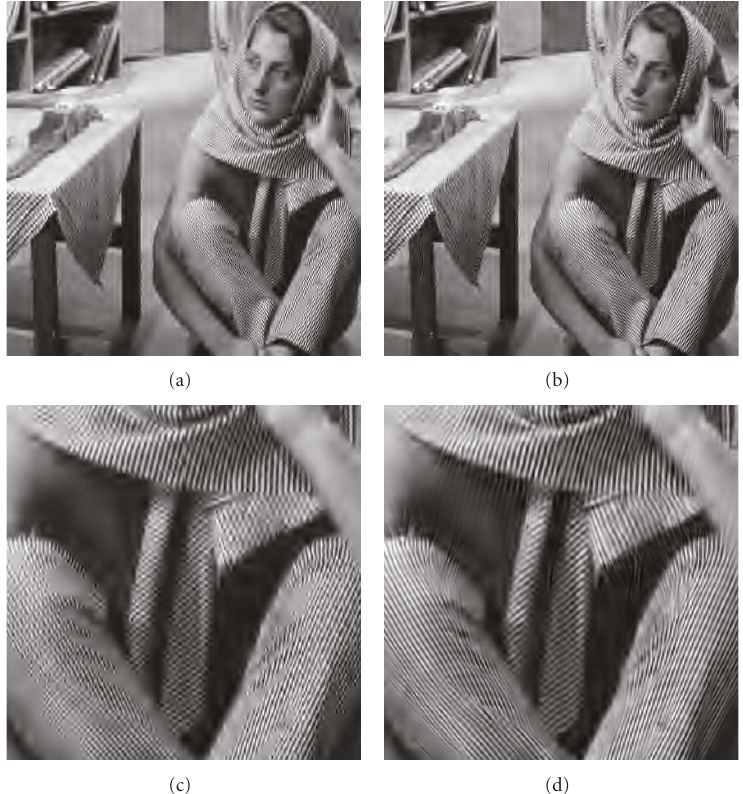
Figure 21: Reconstructed Barbara images at 0 . 15bpp using (a) JPEG2000, PSNR = 25 . 93 dB and (b) PDFB, PSNR = 26 . 74 dB. (c) and (d) are zoom-in images of (a) and (b),